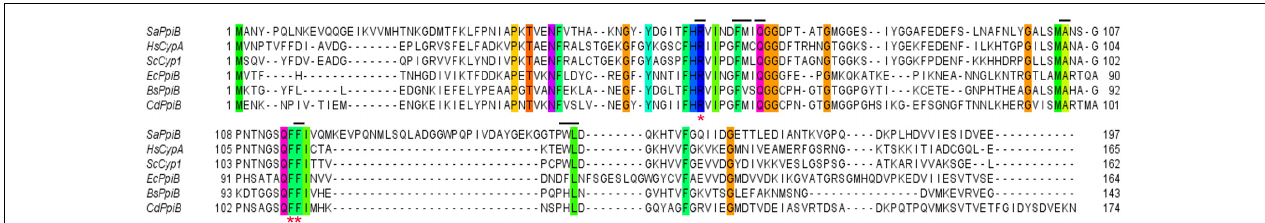
FIGURE 1 | CdPpiB is a classical cyclophilin-type PPIase. The alignment of amino acid sequences of cyclophilin type PPIases of the Gram-positive species S. aureus (SaPpiB; Q2FZU9), C. difficile (CdPpiB; Q18D70) and B. subtilis (BsPpiB; P35137) as well as the Gram-negative model organism E. coli (EcPpiB; P23869), and the yeast (ScCyp1; P14832) and human CypA (HsCypA; P62937) reveals highly conserved amino acids along the PPIase active surface (marked by a black line). The alignment was performed using the T-Coffee webserver and visualized by Jalview 2.10.3b1. Amino acids that are conserved to 100% are highlighted by color coding according to Taylor (Taylor, 1986; Notredame et al., 2000; Waterhouse et al., 2009). Amino acids that have been mutated in CdPpiB are marked by an asterisk.